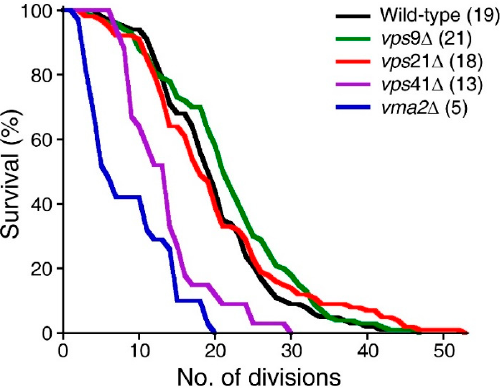
Figure 4. Pma1p asymmetry little correlates with the RLS of the budding yeast Saccharomyces cerevisiae . The RLS of wild-type, vps9 Δ , vps21 Δ , vps41 Δ , and vma2 Δ cells was measured by micromanipulation as described in the Materials and Methods section. Median lifespan is indicated in parenthesis ( n = 32 for wild-type, n = 32 for vps9 Δ , n = 32 for vps21 Δ , n = 33 for vps41 Δ , and n = 31 for vma2 Δ ).